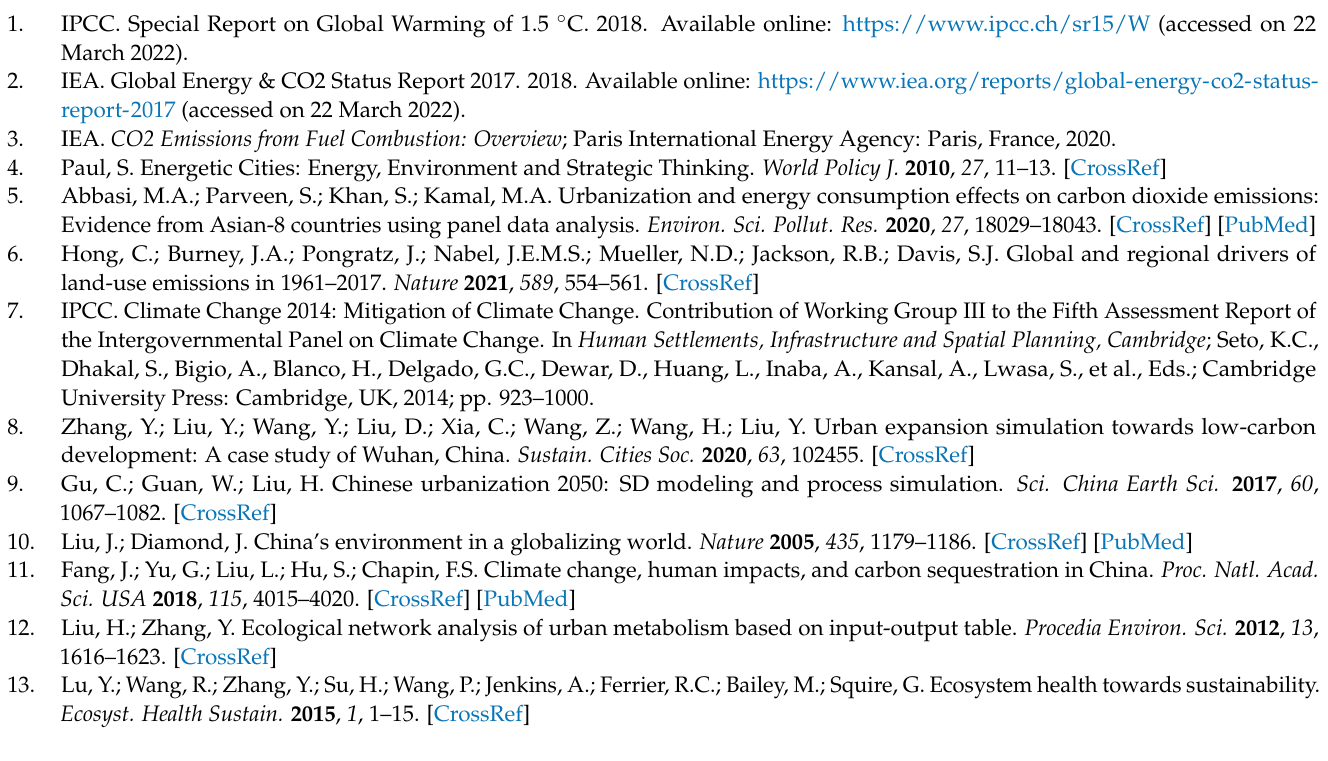
Table S1: Different land use types areas in each year; Table S2–S7: Land transition matrix from 1990–2018; Table S8: IPCC carbon emission conversion coefficients for the energy types consumed in the study area [65]; Table S9: Carbon emission conversion coefficients for the respiration accounting items [65,104,105]; Table S10: The city’s population and livestock numbers during the study period; Table S11: The conversion coefficients for carbon emission of cultivated land [106]; Table S12: Carbon sequestration coefficients for the natural components of the urban network [107–113]; Table S13: Categories for the total direct and integrated input flows for each component of Beijing’s carbon metabolism; Table S14: Scenarios description in 2035 and 2060; Table S15: Carbon metabolic intensity for the different land use types in each